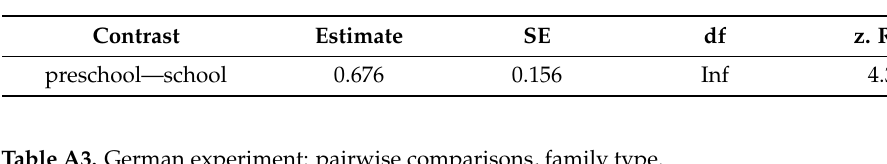
Table A2. German experiment: pairwise comparisons, age group.